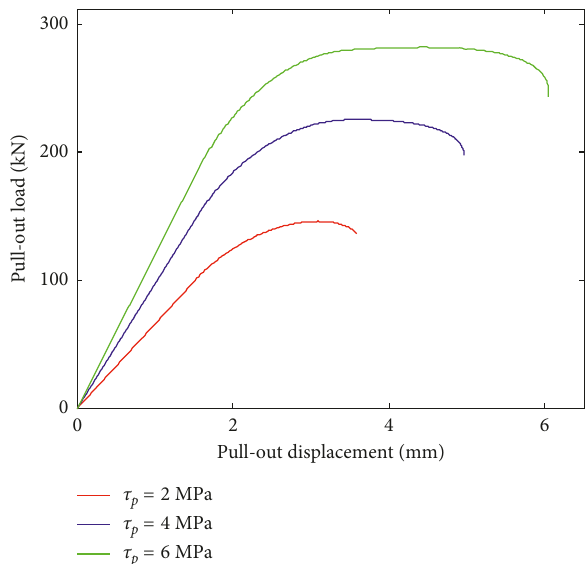
Figure 12: Load transfer performance of rock bolts when the shear strength of the bolt/grout interface was